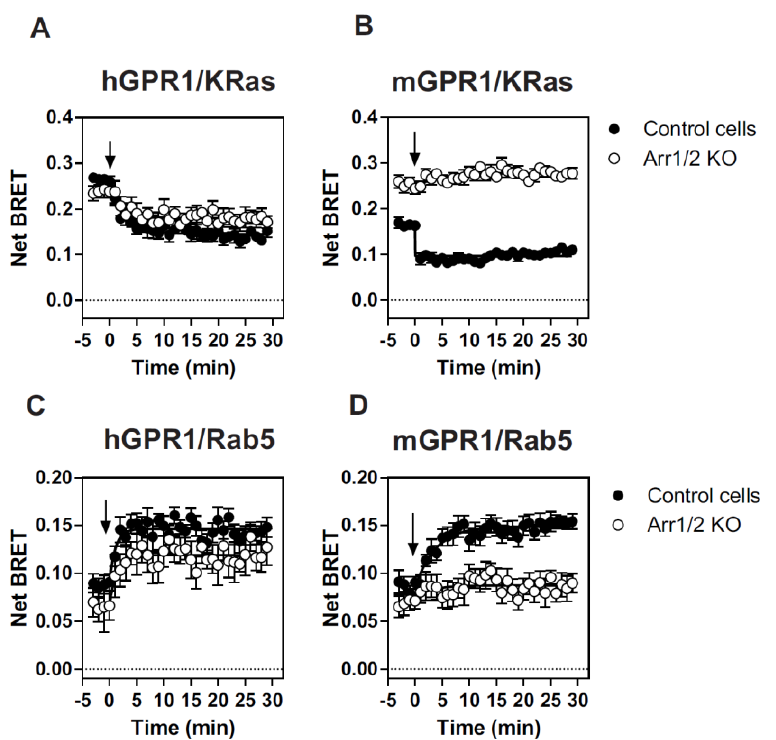
Figure 3. β -arrestins are involved in mGPR1 subcellular localization and trafficking. ( A – D ) Real-time measurement of BRET signal in WT ( • ) or β -arrestin 1/2 KO ( ◦ ) HEK293 cells expressing hGPR1- RLuc or mGPR1-RLuc in combination with KRas-Venus (plasma membrane) ( A , B ) or Rab5-Venus (early endosomes) ( C , D ), in cells expressing or not basal conditions and after stimulation with 100 nM chemerin. Results are expressed as Net BRET corresponding to the BRET signal measured between the donor and the acceptor minus the BRET signal measured with the donor only. Data represent the mean ± SEM of at least three independent experiments.